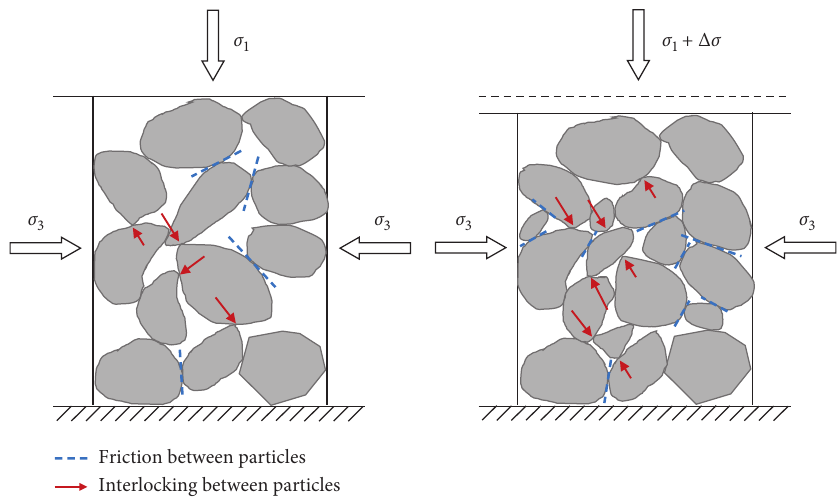
Figure 9: Sketch of deformation mechanism of calcareous